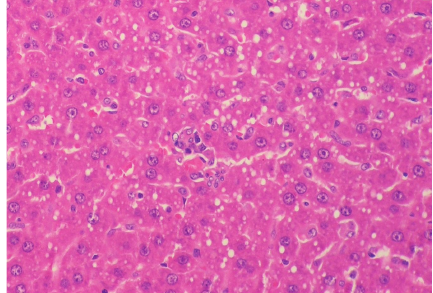
Figure 10: Histopathologic sections of liver (HE, x200), A: control